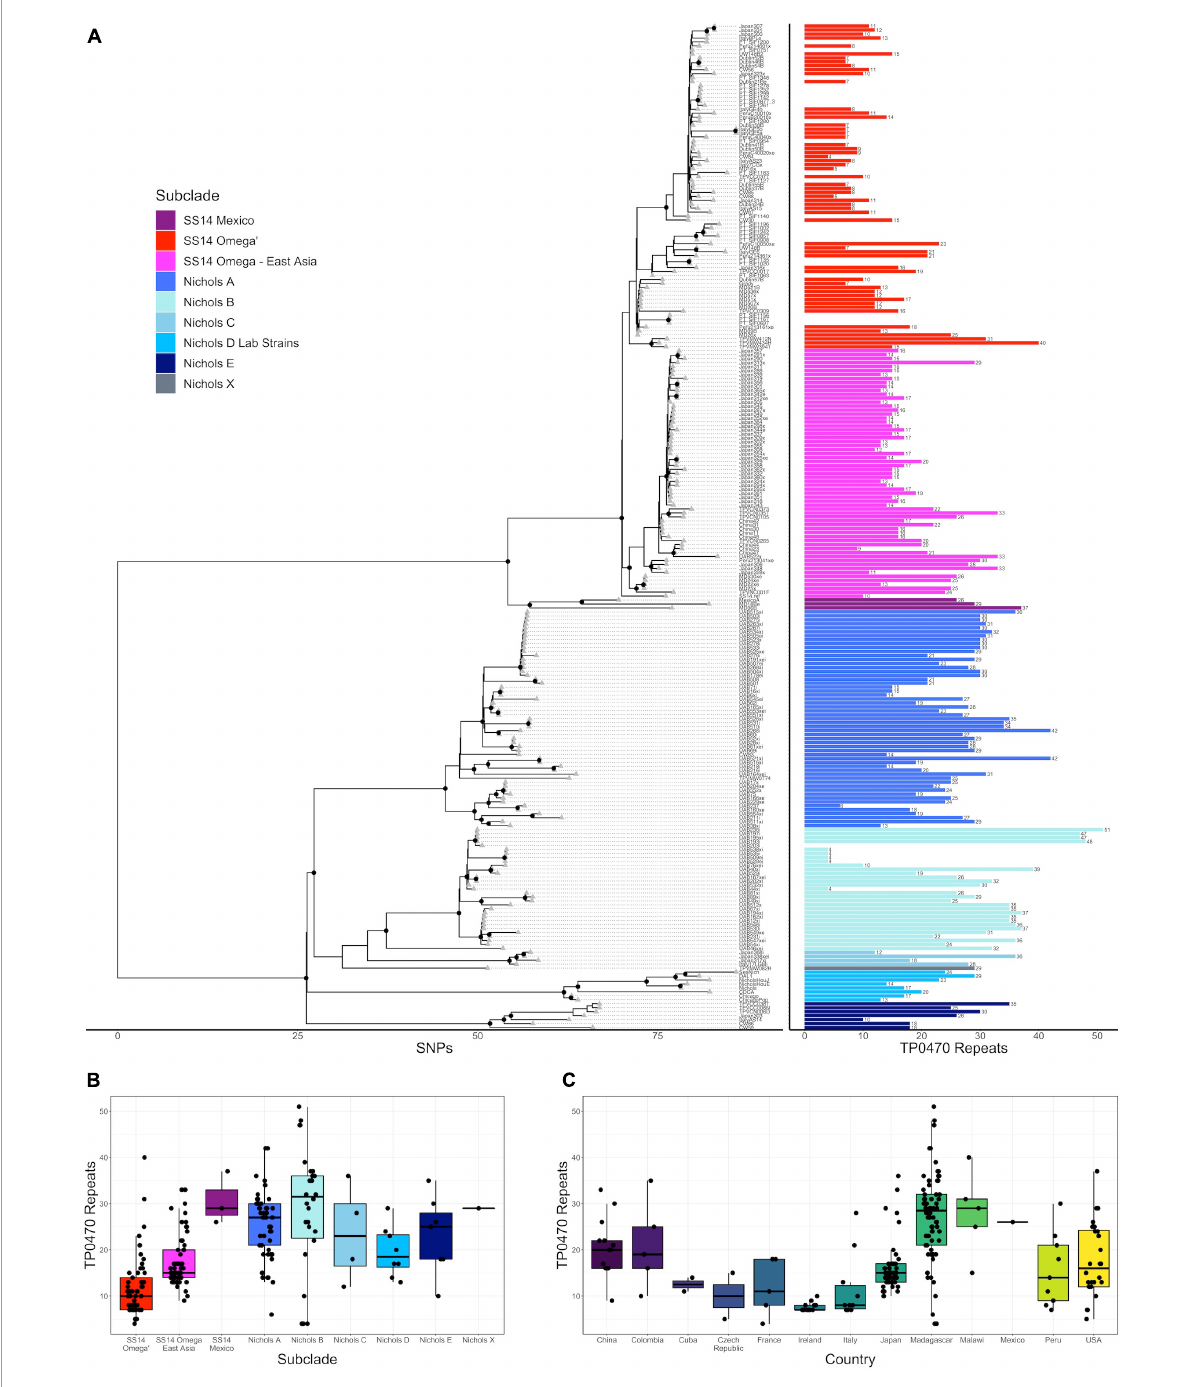
FIGURE1 Variation in tp0470 repeat length. (A) Recombination masked whole genome phylogeny (left) with the number of tp0470 repeats for each strain (right). Sequence variant number is included as text to the right of each length bar. All data are also included in a tabular representation in Supporting Information. Number of tp0470 repeats by subclade (B) or country (C) .